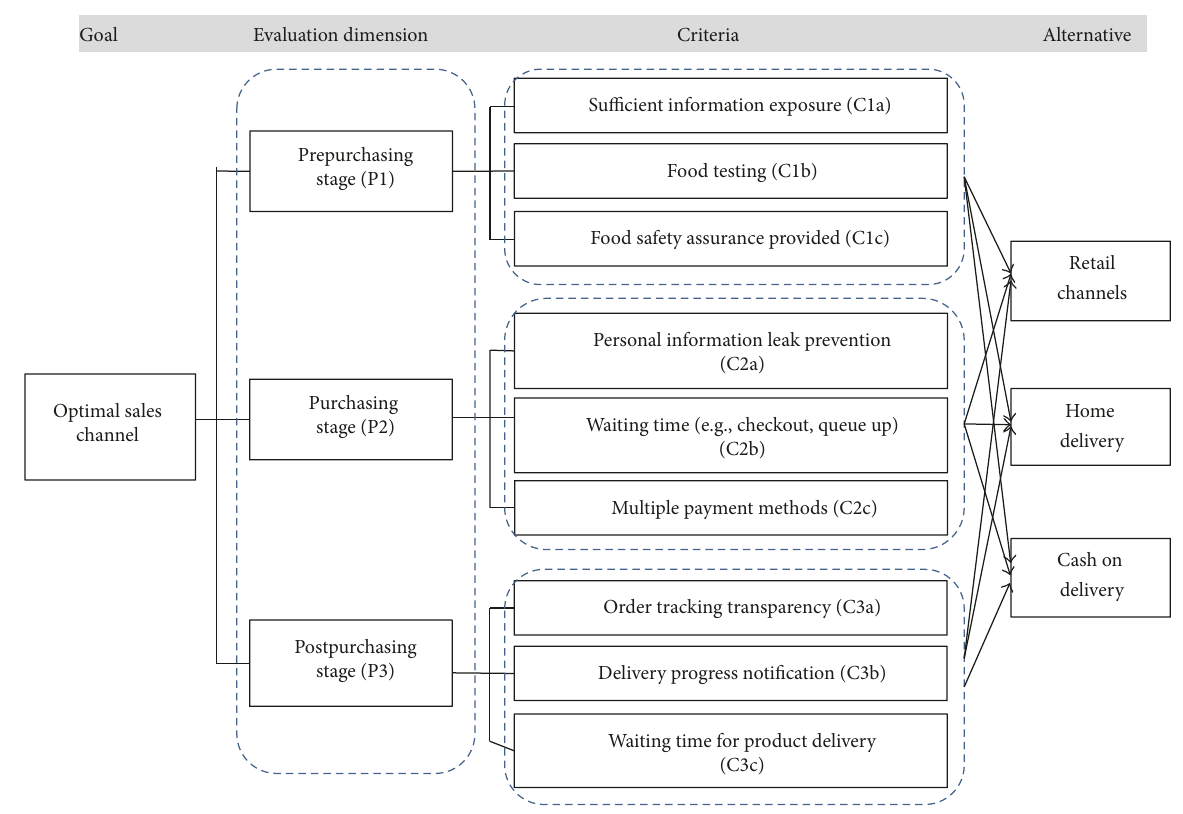
Figure 1: Architecture diagram of fresh snack food marketing